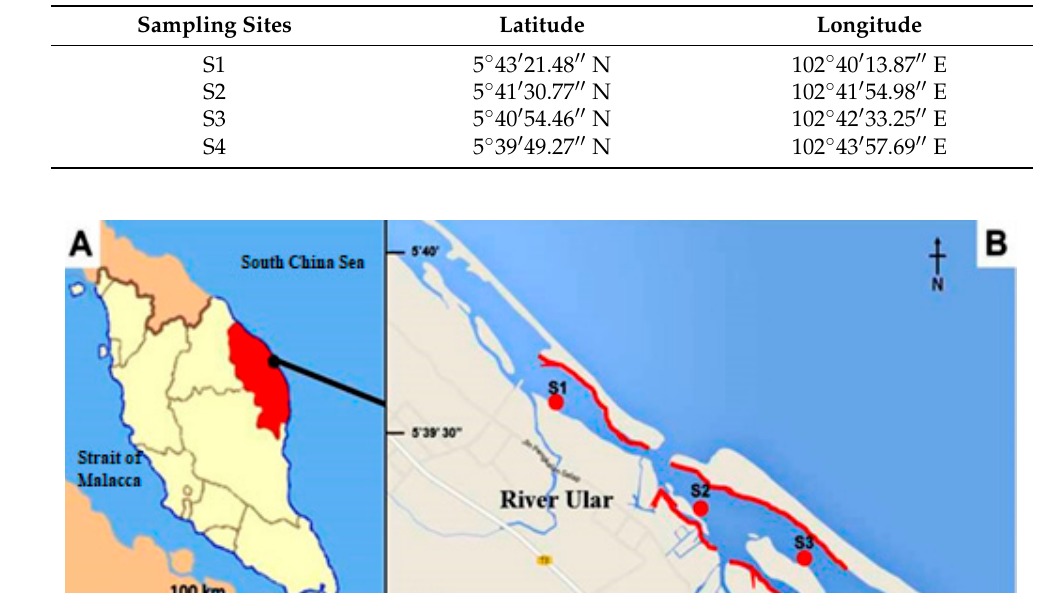
Table 1. Information of each sampling sites.